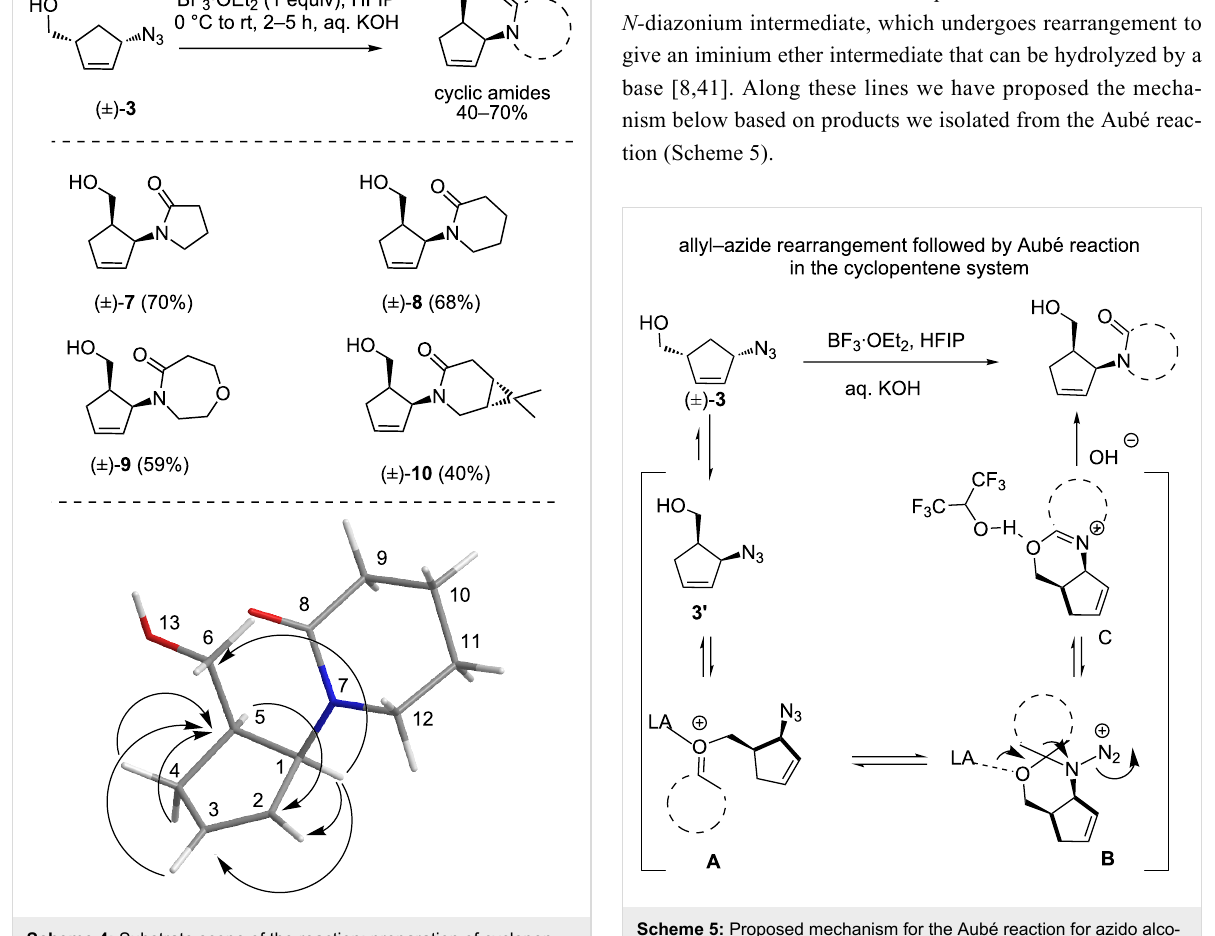
Scheme 4: Substrate scope of the reaction: preparation of cyclopen- tene-substituted lactams and key NMR correlations (HMBC) of com- pound (±)- 8